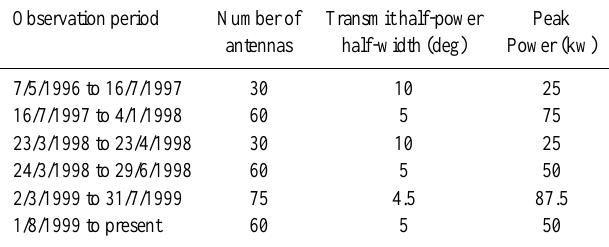
Table 2. Observation periods for routine spaced antenna